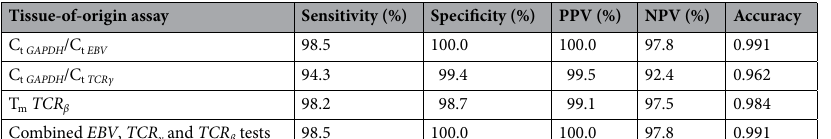
Tissue-of-origin